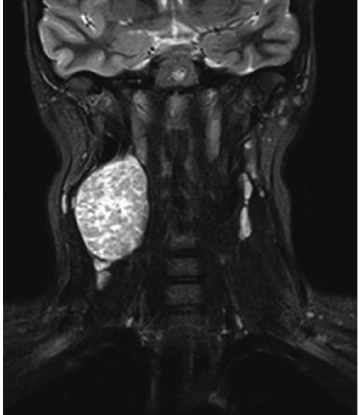
Figure 2: MRI head and neck showing a 3.9 × 3.8 × 6.1cm lesion with a heterogeneous enhancement pattern and cervical lymph nodes within normal limits.